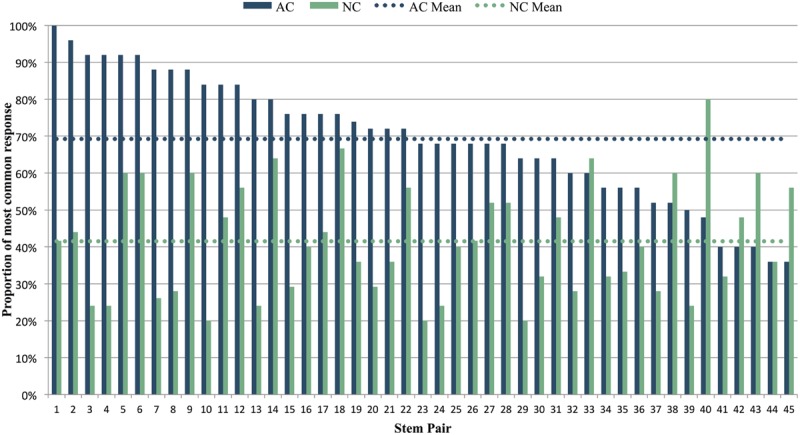
Constraint of AC and NC stems, as calculated by the percentage of participants providing the most common response for each stem. Stem pairs are ranked in order of decreasing constraint for AC stems. The melodic pair shown in Figure 1 corresponds to stem pair 3 in this graph. Dotted horizontal lines show the mean constraint across all AC and NC stems.